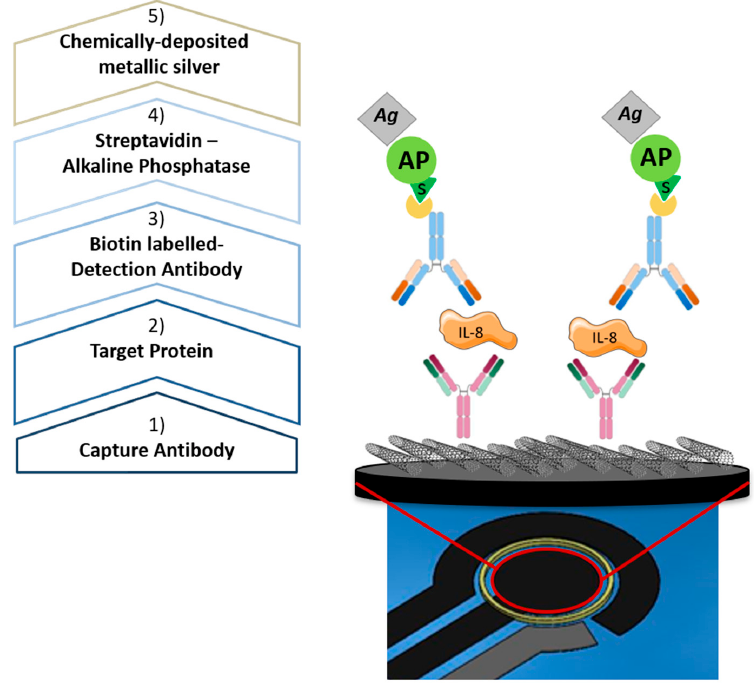
Figure 4. Bio-functionalization protocol for the ASV measurements of IL-8.